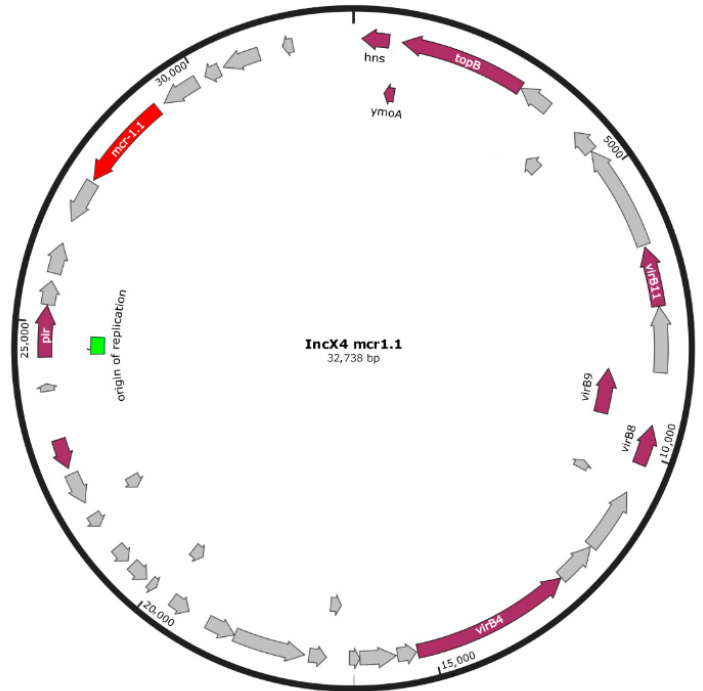
Figure 1. IncX4 plasmid content of the S . Infantis isolate, carrying mcr1.1.